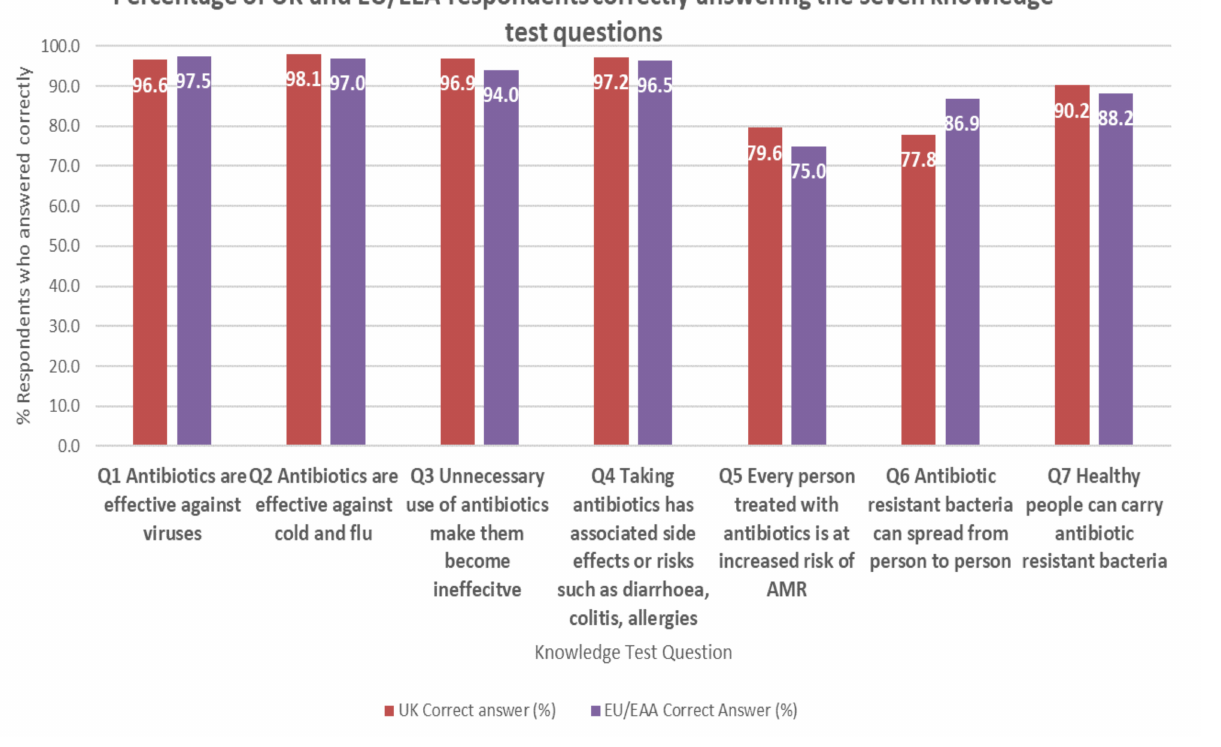
Figure 2. Percentage of UK ( n = 2403) and EU/EEA respondents ( n = 18,348) correctly answering the seven knowledge test